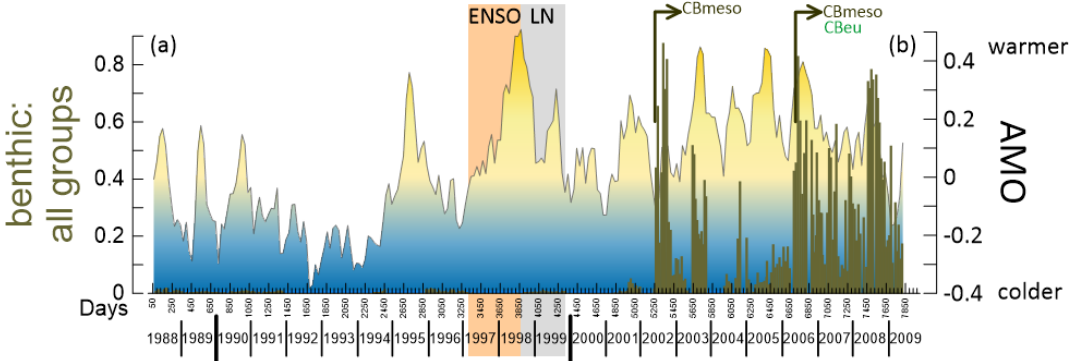
Figure 6. Time series of ratio benthic:all groups (olive bars, a ) at the site CBmeso and the Atlantic Multidecadal Oscillation (AMO, b ) between March 1988 and May 2009. The fill in (b) represents the colder phase (blue) and the warmer phase (yellow) of AMO. Inverted arrows in the lower panel below the benthic:all group bars represent the abrupt increase in relative contribution of benthic diatoms, first seen at CBmeso in early winter 2002 and in winter 2006 at CBmeso and at CBeu (Romero and Fischer, 2017; Romero et al., 2020). Shadings in the background: light orange, El Niño–Southern Oscillation (ENSO); grey, La Niña (LN). For interpretation of the references to color in this figure legend, the reader is referred to the web version of this